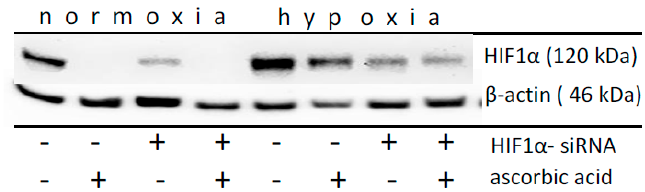
Figure 6. Impact of ascorbic acid on the normoxic and hypoxic HIF1 α level in MDA ‐ MB ‐ 231 cell. After